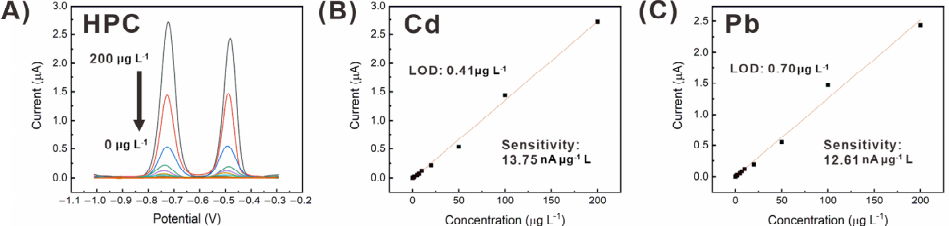
Figure 7. ( A ) SWASV plots obtained at various concentrations (0, 1, 2, 5, 7, 10, 20, 50, 100, and 200 µ g L − 1 ) of cadmium and lead in a NaAc buffer, and peak current signals at various concentrations